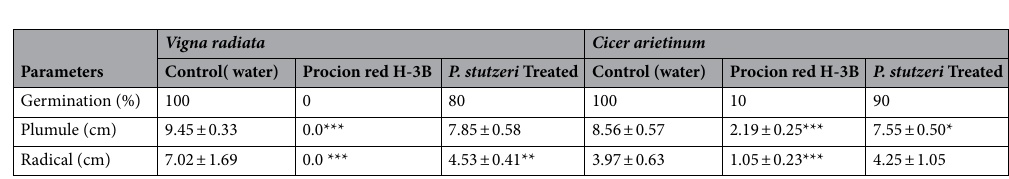
Table 3. Phytotoxicity study of Procion red H-3B and its degradation product. Values are mean of three experiments, SD ( ±), significantly different from the control (seeds germinated in water) at * P < 0.05, ** P < 0.01, *** P < 0.001 by ANOVA with Tukey–Kramer comparison test a 500 ppm